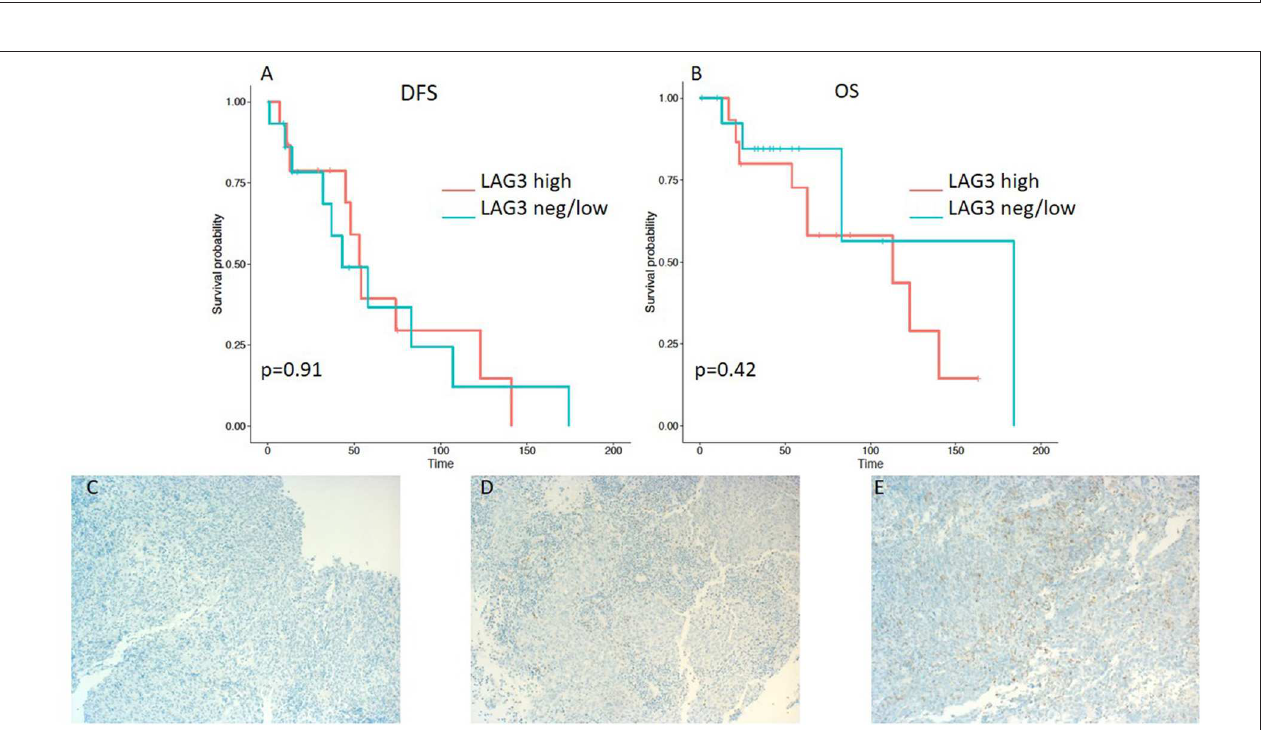
FIGURE 3 | Kaplan–Meier curves for DFS (A) and OS (B) according to LAG3 expression on tumor infiltrating lymphocytes (TILs) (neg/low vs. high). Representative images of LAG3 expression on TILs: (C) negative, (D) low, and (E) high (x100 magnification). Log-rank tests were performed, and p -values are depicted.